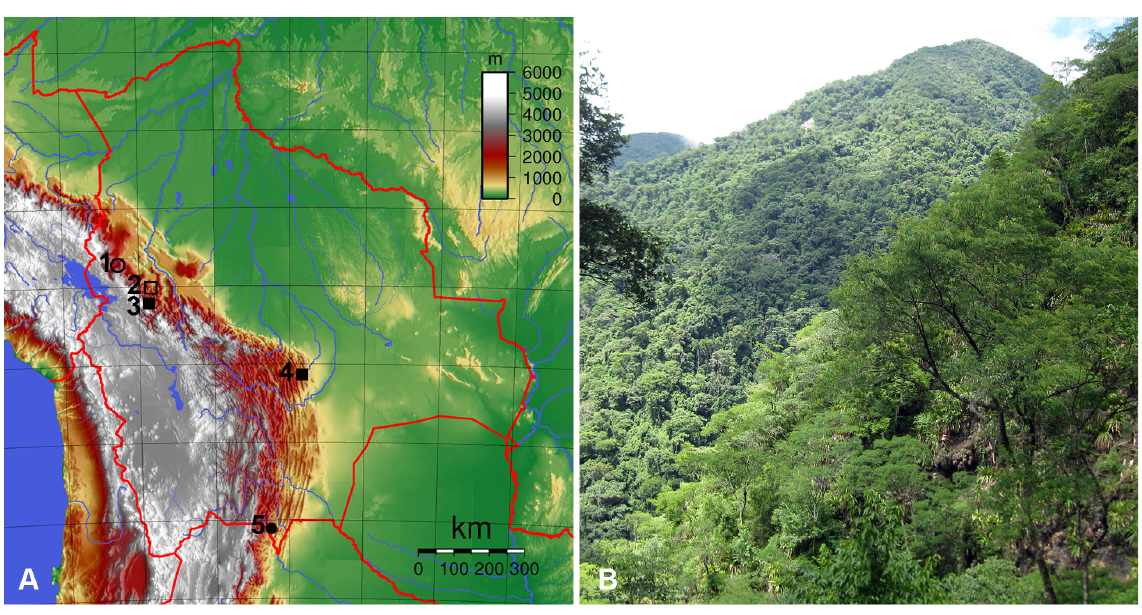
Fig. 1. A . Bolivian records of Auxicerus platyceps Waterhouse, 1883 (open circle, solid rectangle); Auxicerus multicolor (Boileau, 1897) (open rectangle, solid rectangle) and Auxicerus magnipunctatus sp. nov. (solid circle). Localities: (1) Consata, (2) Caranavi, (3) Coroico, Chairo, (4) Los Volcanes and (5) Emborozu. B . Habitat of Auxicerus magnipunctatus sp. nov. in humid Tucuman-Bolivian